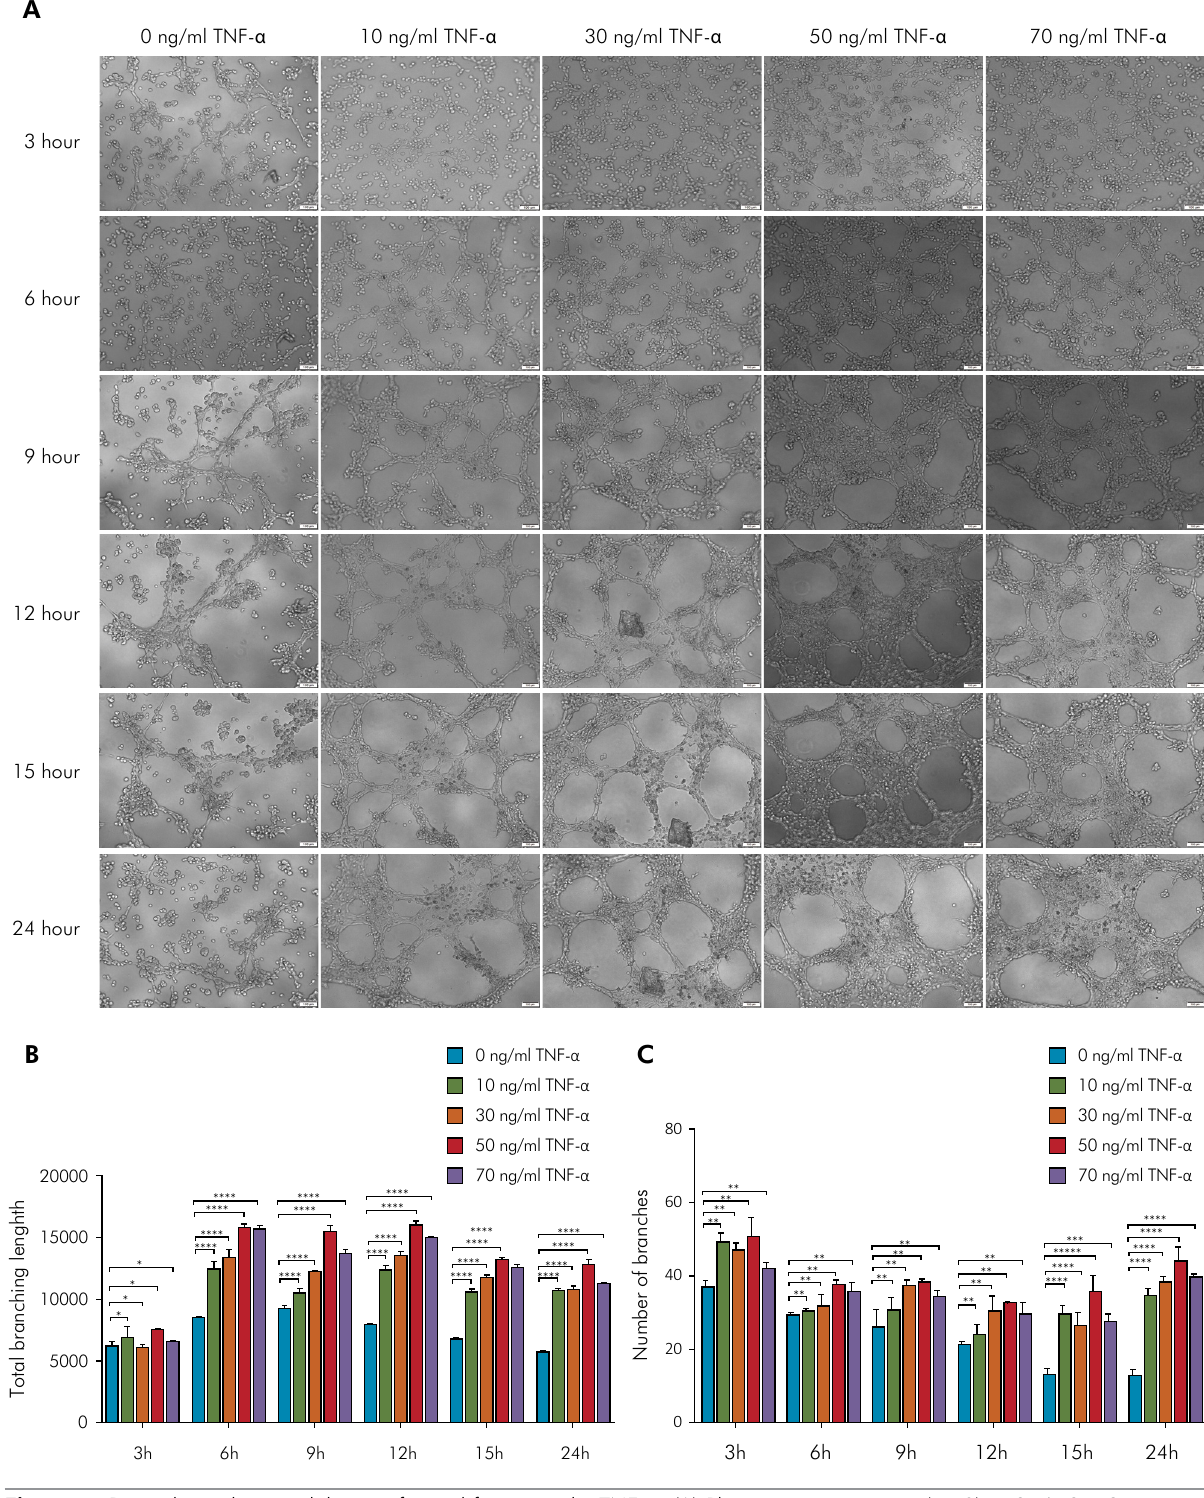
Figure 1. Dose-dependent modulation of vessel formation by TNF- α . (A) Phase-contrast images (×10) at 3, 6, 9, 12, 15, and 24 h after the addition of 0, 10, 30, 50, and 70 ng/ml TNF- α to the co-culture system (HUVECs:hDPSCs = 5:1), with seeding on Matrigel. (B, C) Graphic representations of the total branching length and number of branches, respectively. Data are presented as means ± standard deviations (n =